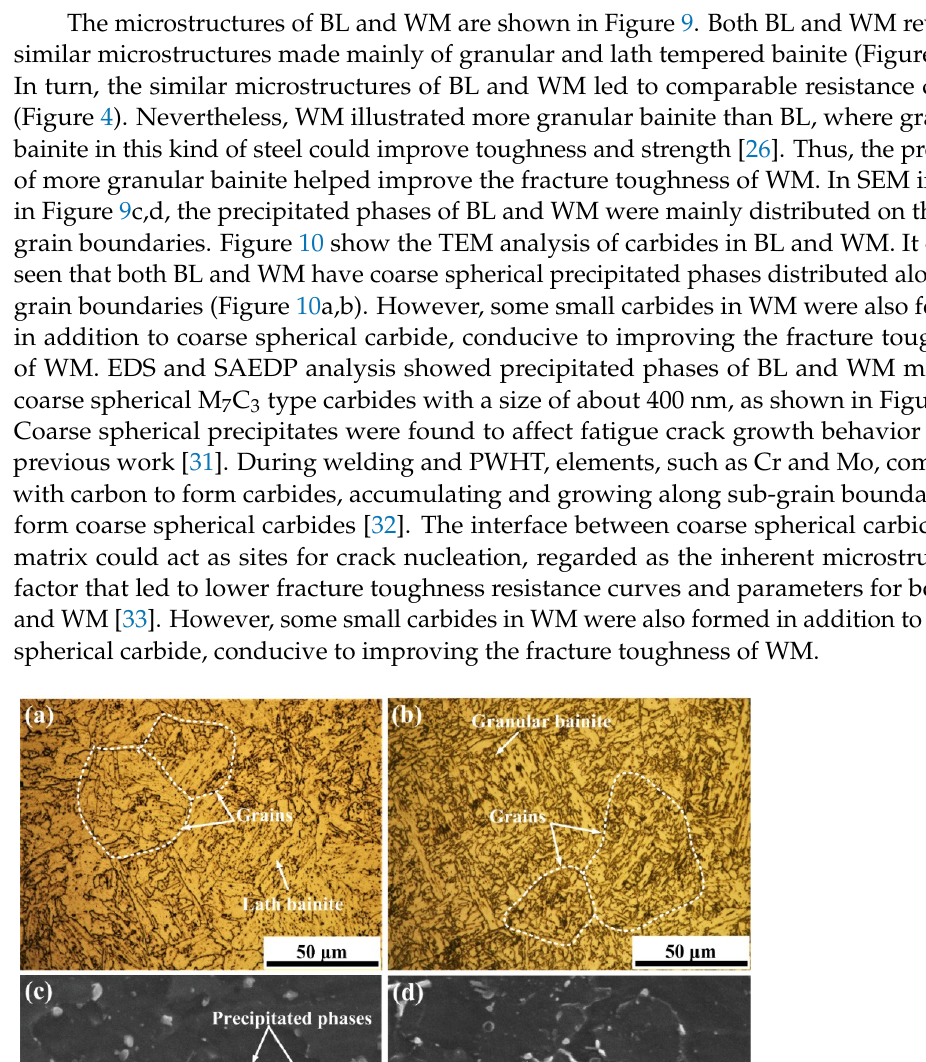
Figure 8. TEM analysis of BM-1. ( a ) Bright-field image. ( b ) Carbide in ( a ) analyzed by SAEDP.